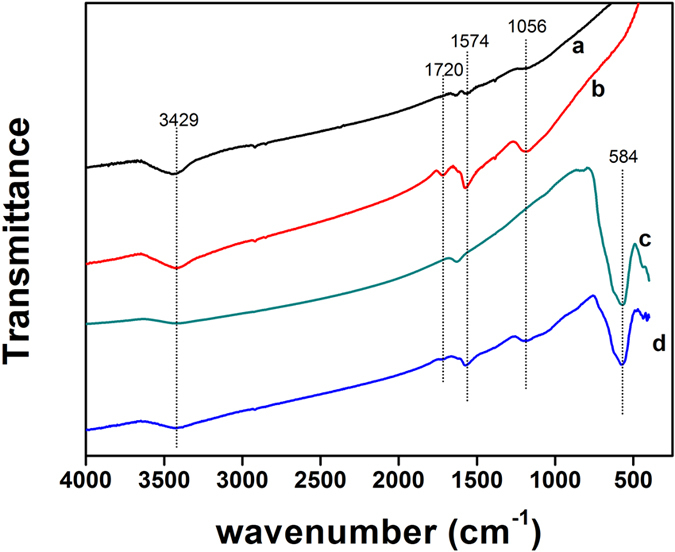
FT-IR spectra of MWCNTs (curve a), MWCNTs-COOH (curve b), Fe3O4 nanoparticles (curve c) and MWNTs-Fe3O4 (curve d).